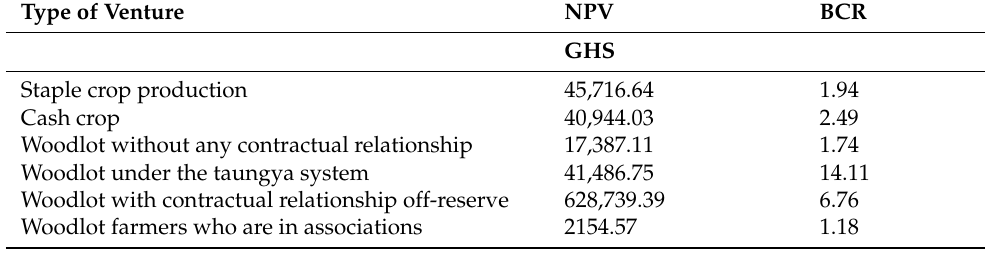
Table 6. NPV and BCR of agriculture and woodlot production.